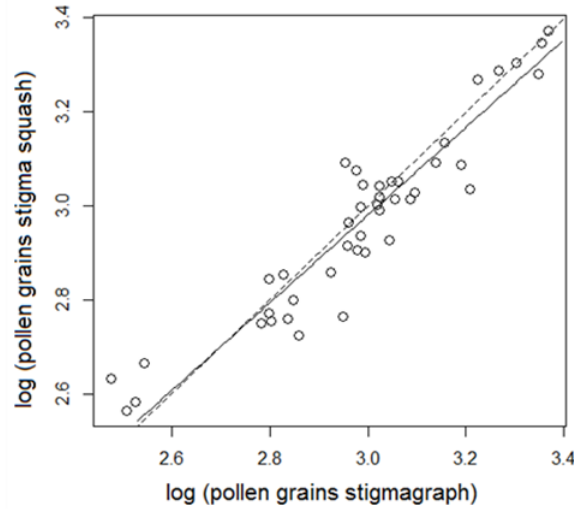
F IGURE 5. The relationship between the number of pollen grains determined by the ICT method in stigmagraphs and the number of pollen grains determined by stigma squashes for two species of daffodil (N. pseudonarcissus and N. nanus). The SMA regression line (solid) has slope = 0.93 ± 0.09, i.e. not significantly different from 1, and intercept = 0.18 ± 0.3, i.e. not significantly different from 0. The dotted line is the 1:1 line. N = 44 observations of 22 stigmas; R 2 = 0.88.